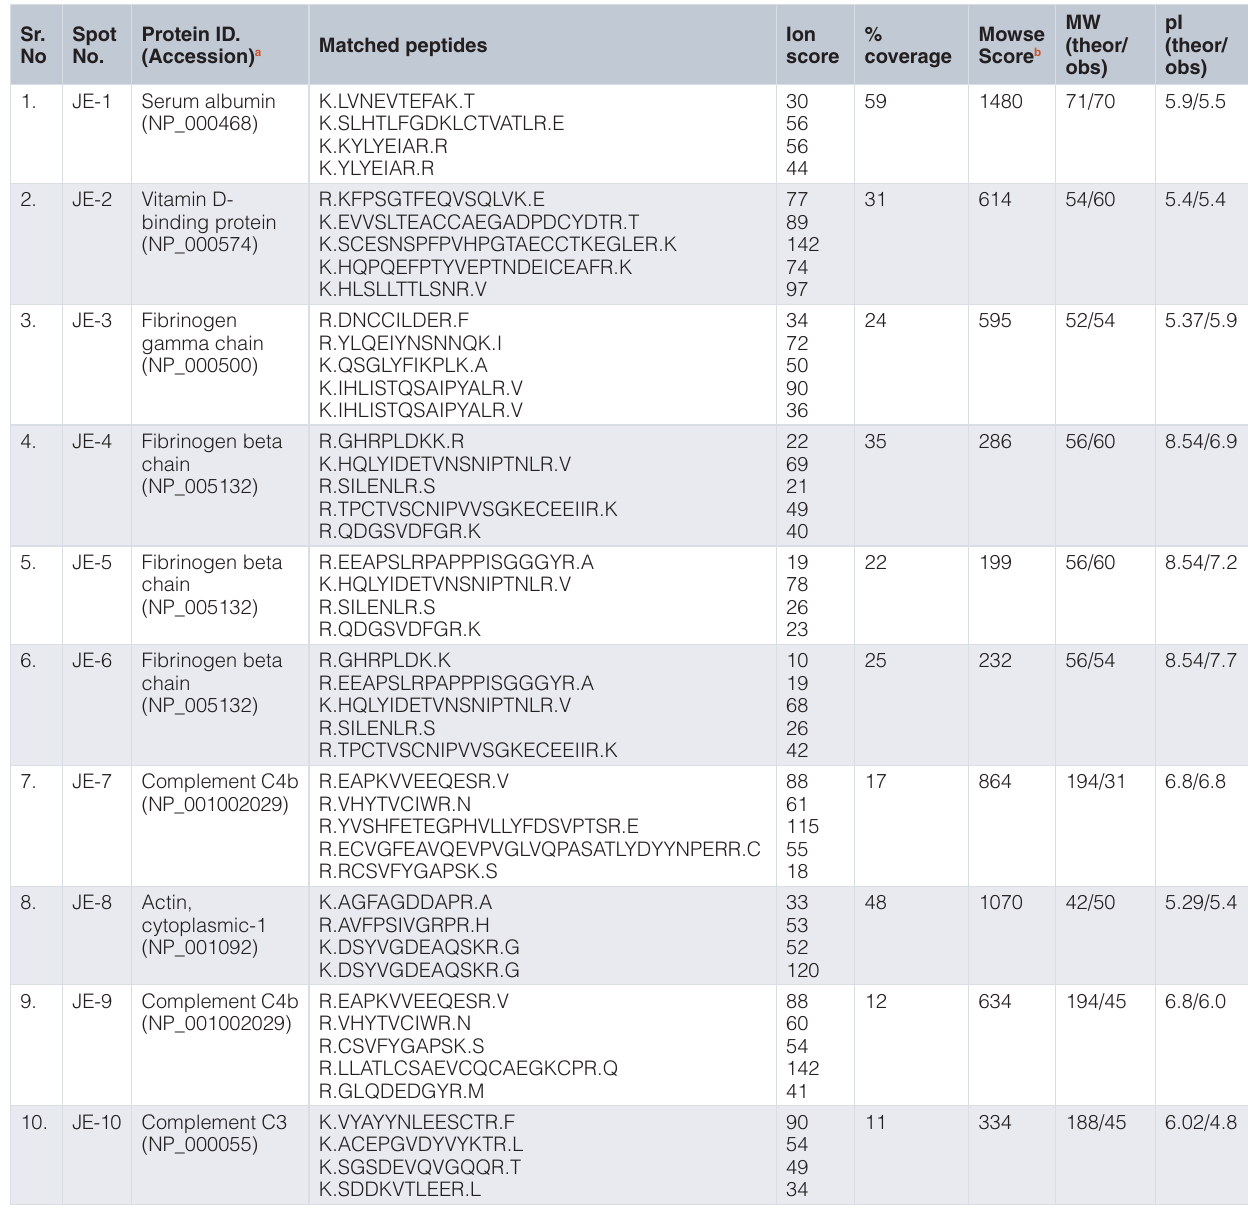
Table 2. Proteins exclusively visualized in the CSF of JEV infected patients, identified by MS/MS analysis of excised spots. Sr. Spot No No.